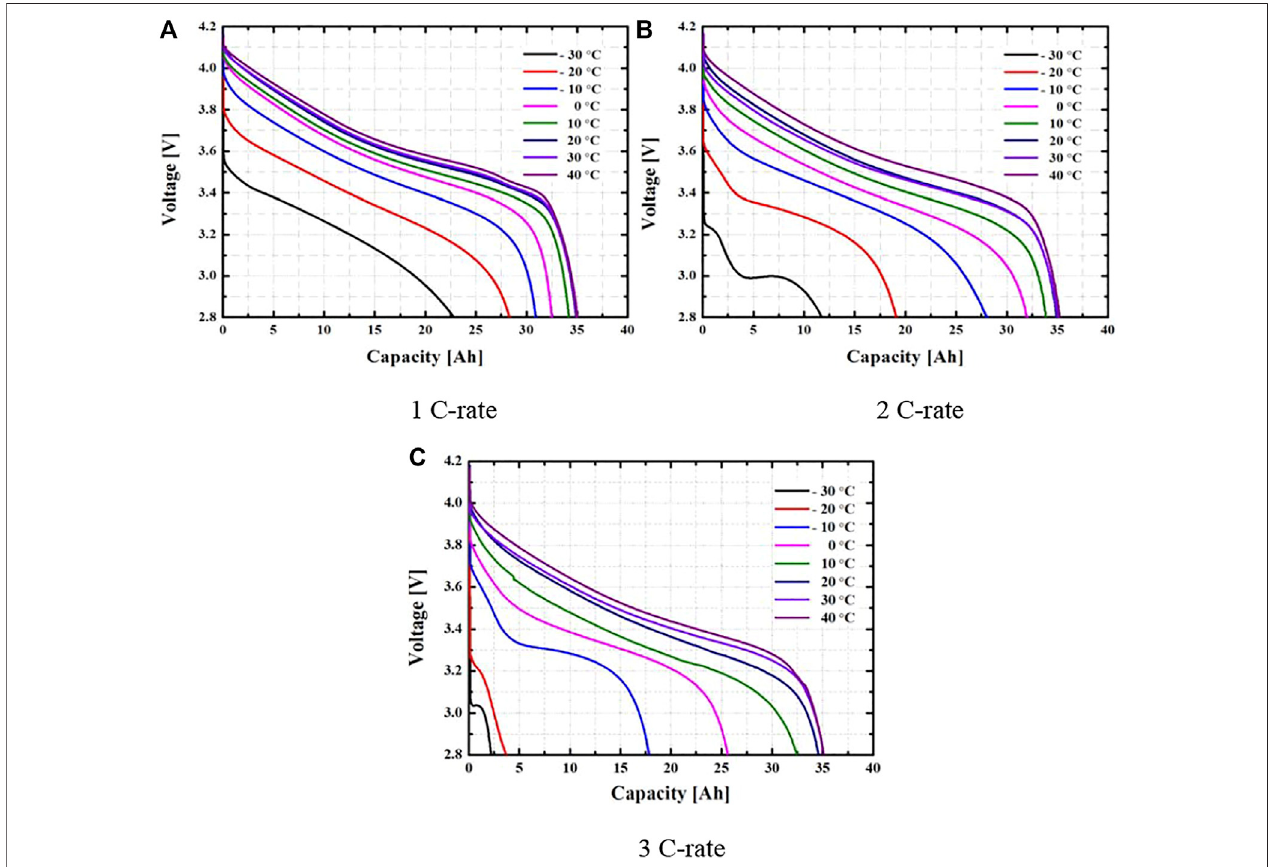
FIGURE 3 | Discharge voltage according to environmental temperature change at each discharge rate. (A) 1 C-rate. (B) 2 C-rate. (C) 3